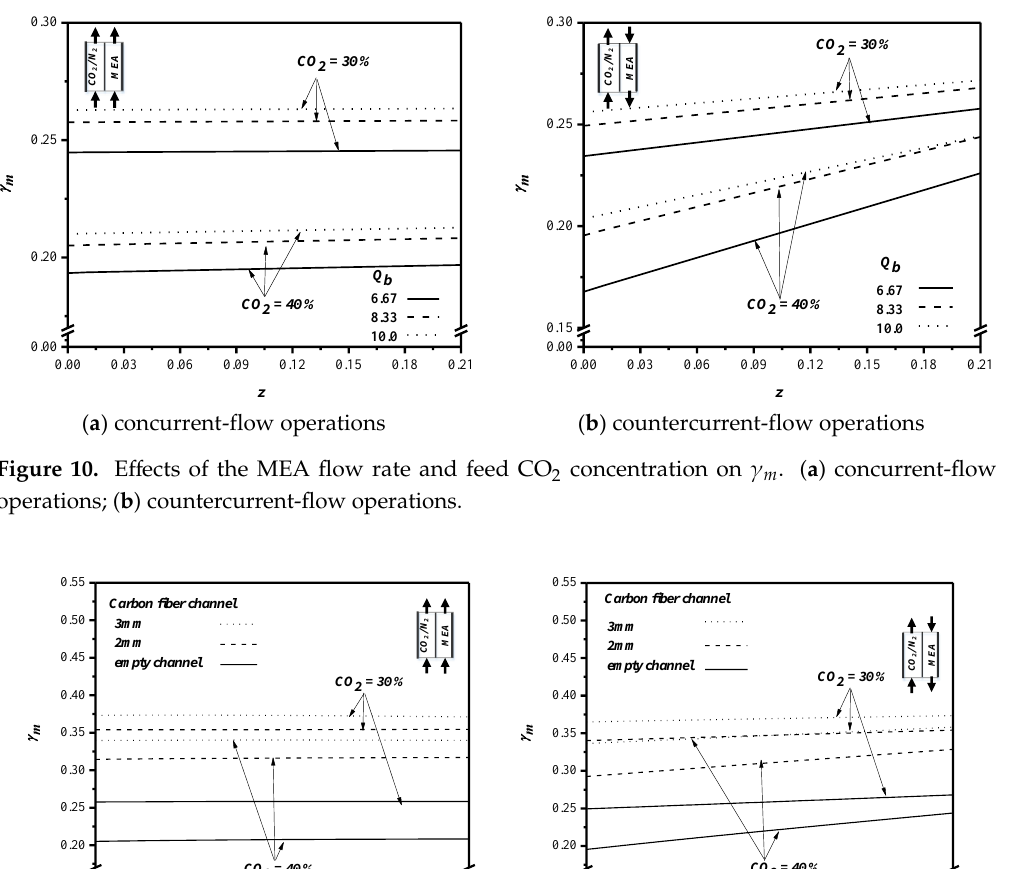
Figure 10. Effects of the MEA flow rate and feed CO 2 concentration on m γ . ( a ) concurrent-flow operations; ( b ) countercurrent-flow operations.